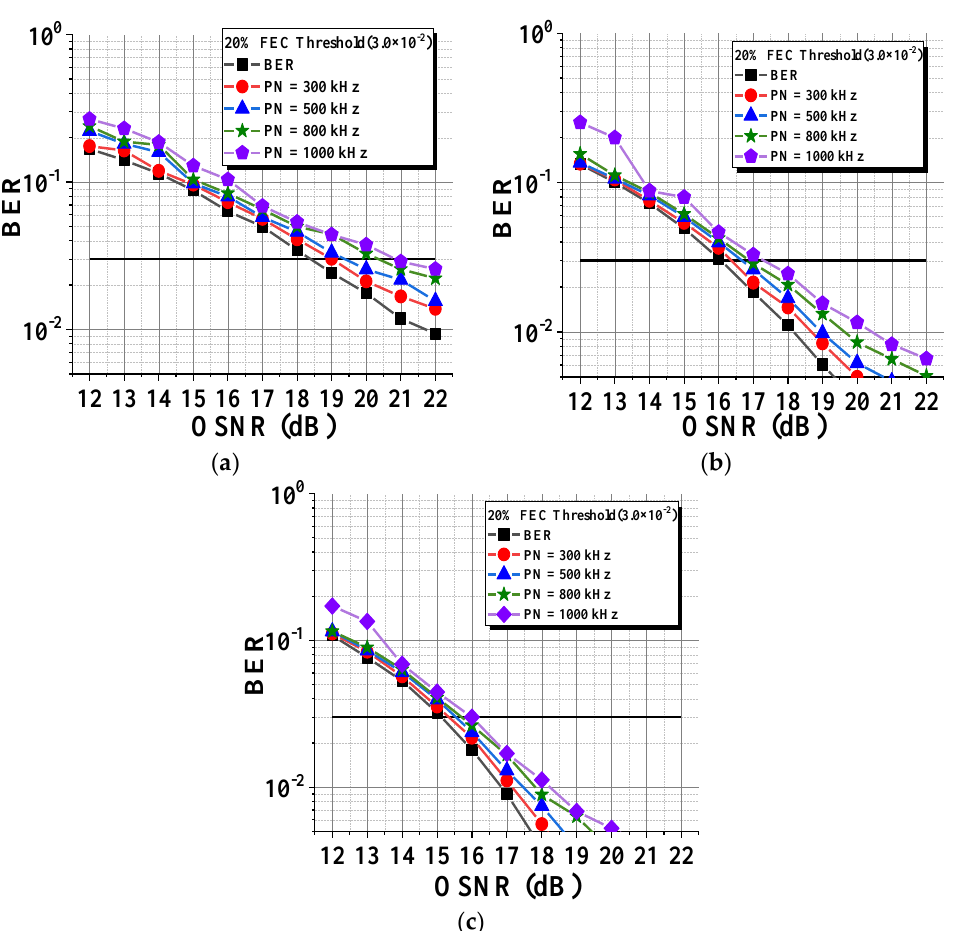
Figure 8. Under the different time-packing factors, the performance of OSNR versus BER is shown for the modified-BPS algorithm to equalize PN when the linewidth equals 300 kHz, 500 kHz, 800 kHz and 1000 kHz, respectively, and ( a ) the time-packing factor equals 0.45; ( b ) the time-packing factor equals 0.50; ( c ) the time-packing factor equals 0.55.